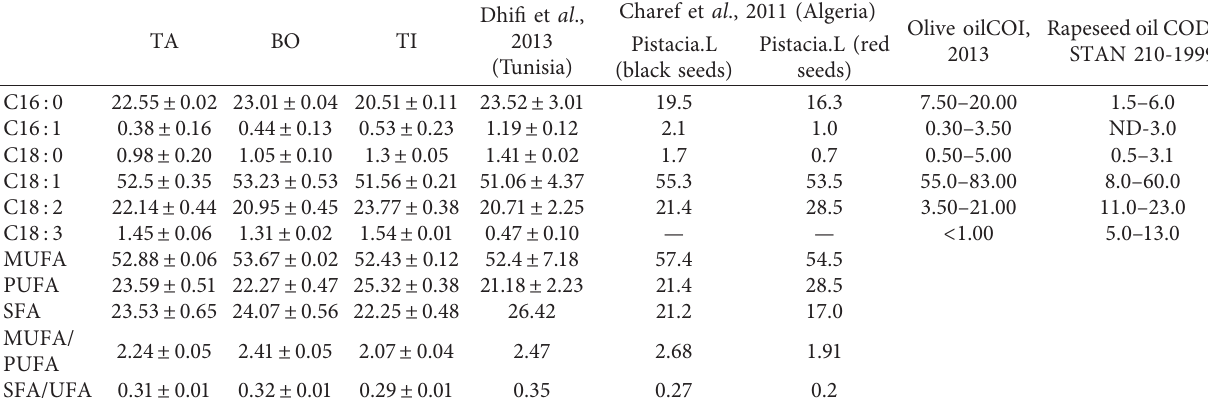
Table 2: Pistacia lentiscus seed oil fatty acids composition (%).